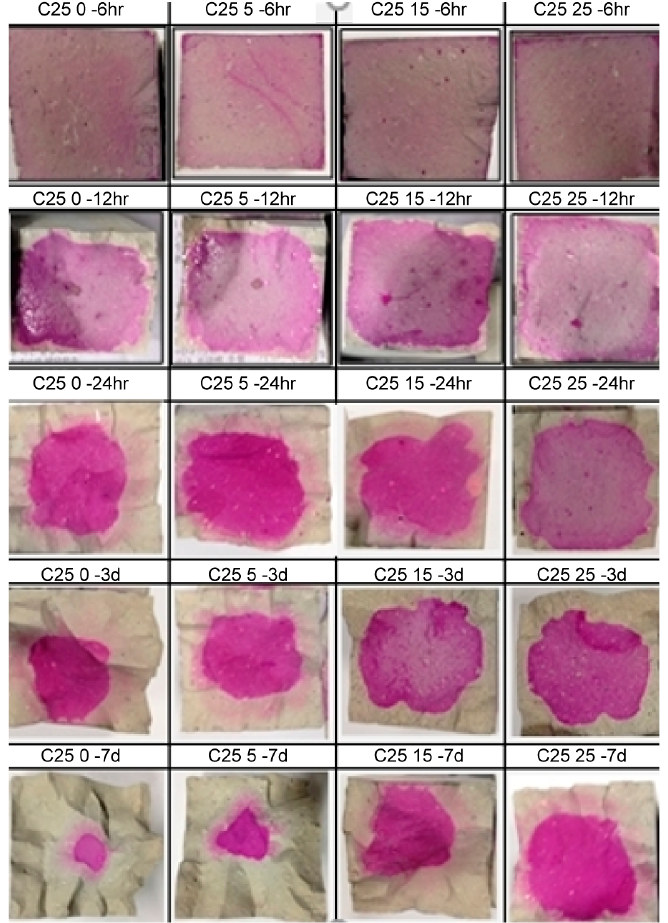
Figure 6. Collection of carbonated specimens sprayed with phenolphthalein indicator, carbonated regions (colorless), and not carbonated regions (purple).